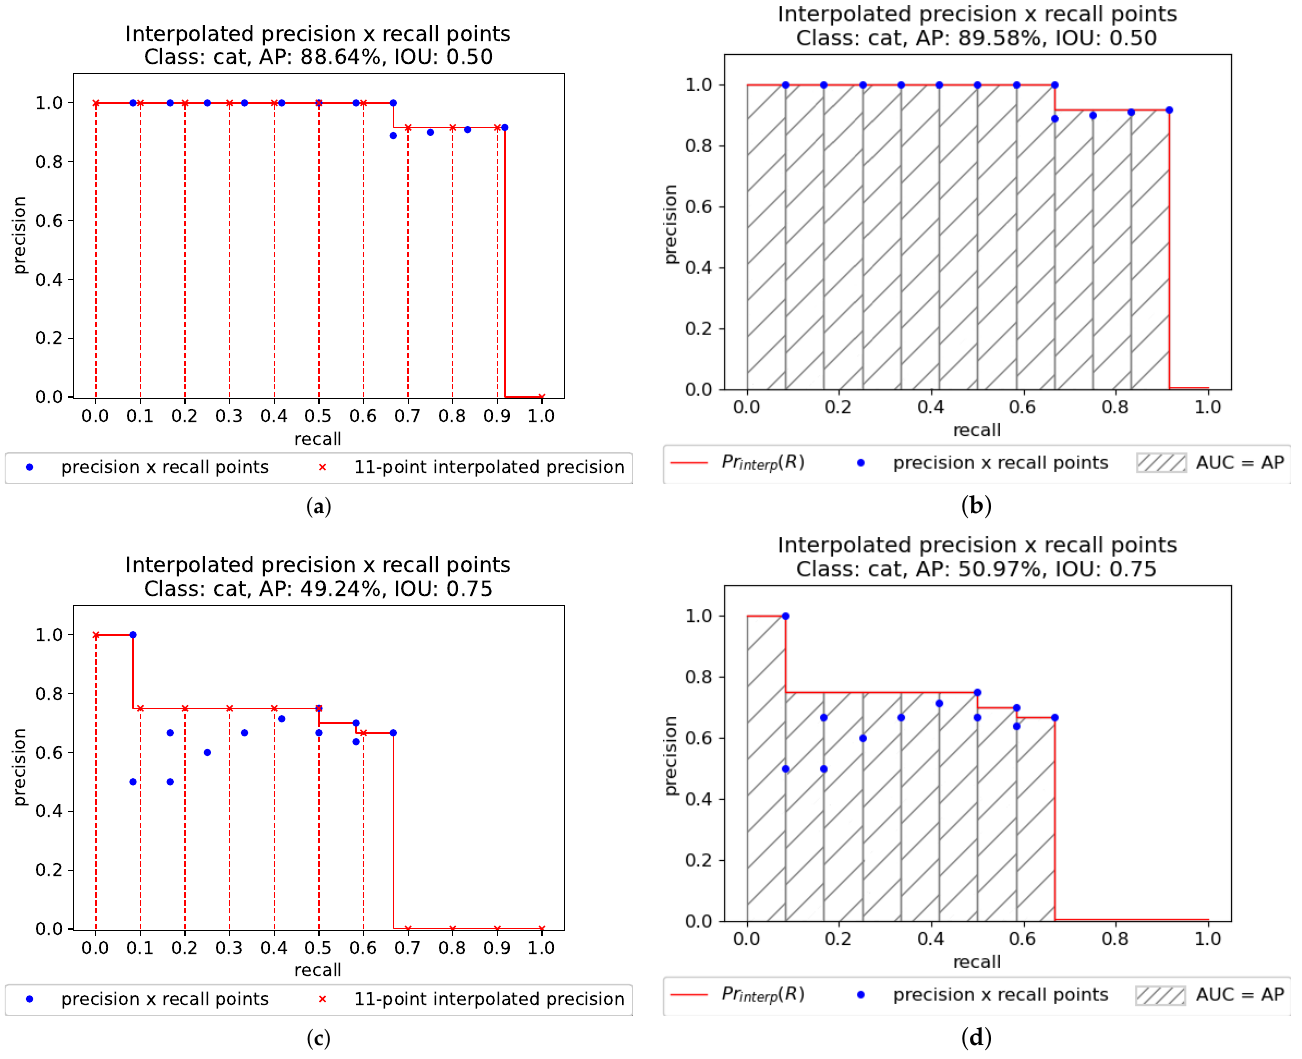
Figure 6. Results for different approaches for computing the AP metric. ( a ) 11-point interpolation with IOU threshold t = 0.5. ( b ) All-point interpolation with IOU threshold t = 0.5. ( c ) 11-point interpolation with IOU threshold t = 0.75. ( d ) All-point interpolation with IOU threshold t =